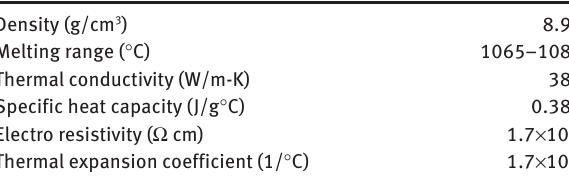
Table 2: Physical and mechanical properties of copper